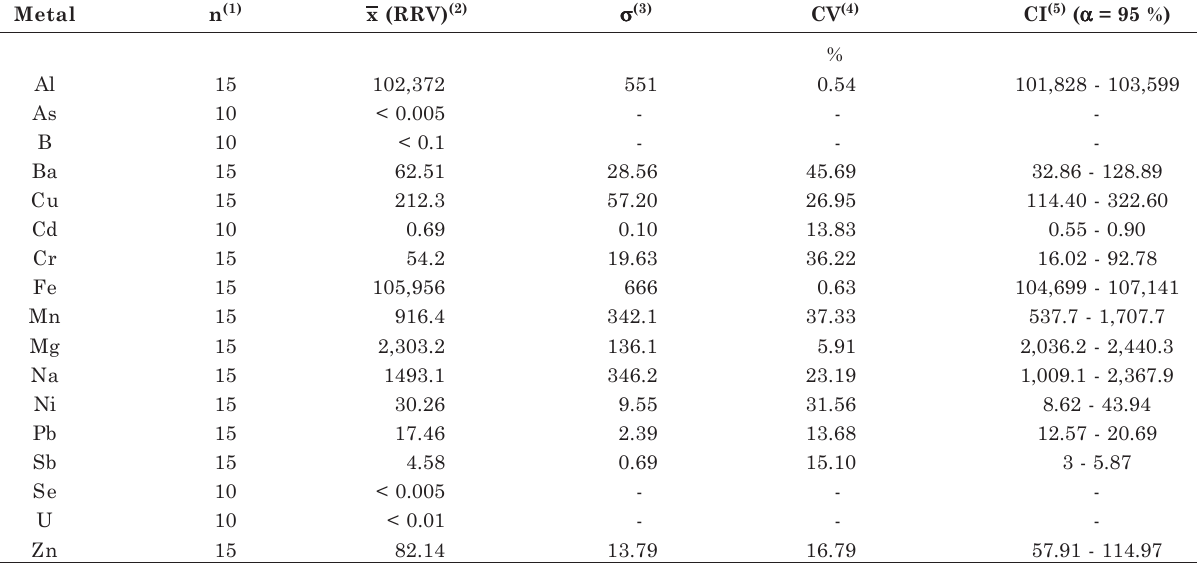
(1) n: number of repetitions; (2) x: mean (RRV: Regional Reference Values); (3) σ : standard deviation; (4) CV: coefficient of variation; (5) CI: confidence